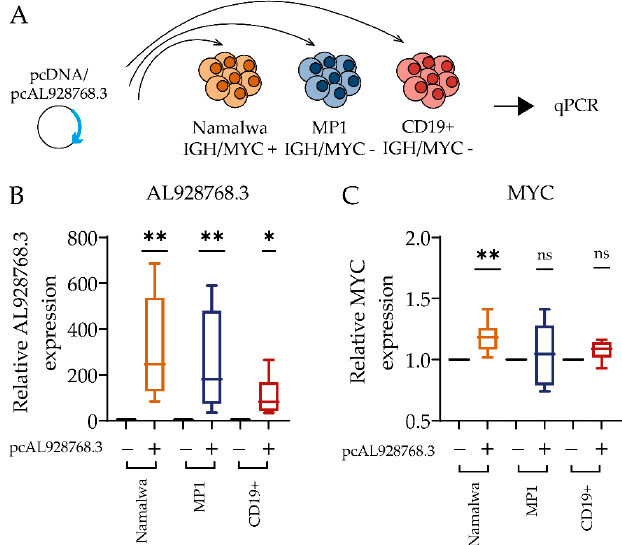
Figure 7. Overexpression of eRNA AL928768.3. ( A ) The scheme of the experiment. Namalwa (n = 8), MP1 (n = 8) cell lines and CD19+ primary B cell (n = 6) were electroporated with plasmid for AL928768.3 expression. The empty vector (pcDNA) was used as a control. Expression data were normalized on the values of the control samples. The figure demonstrates the relative AL928768.3 ( B ) and MYC ( C ) expression in Namalwa, MP1 cell lines and CD19+ primary B cells. * p -value less than 0.05; ** less than 0.01, ns—no significant difference (Wilcoxon test).